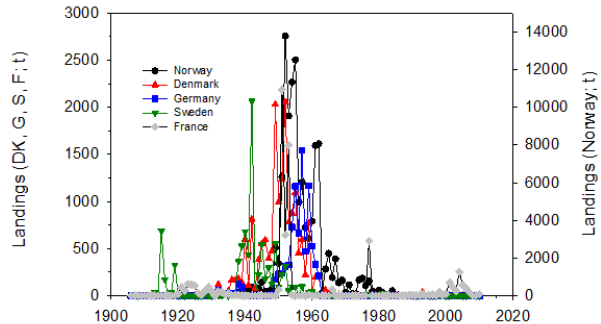
Figure 12. Temporal variability in reported catches of bluefin tuna, Thunnus thynnus , in ICES areas II–VII, by the countries with largest proportions of reported landings. Note that the Norwegian data on the right axis have a different scaling from the other countries. Most (96%) landings occurred in areas II–IV. Data sources include ICES catch databases (versions downloaded 21 January 2014) and other historical sources – see PANGAEA link for